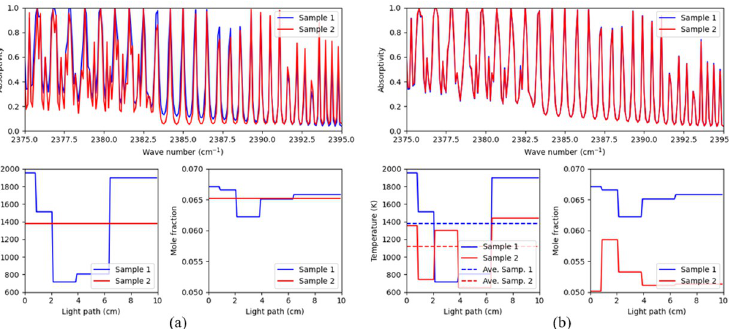
Fig 1. Two cases which occur in profile nonuniformity. In each figure, the top, bottom left and bottom right subplots represent the spectral profile, the temperature profile and the concentration profile, respectively. (a) The samples of uniform and nonuniform profiles have same average temperature and concentration but different spectral appearances. (b) Two samples have visually similar appearances but totally different temperature/concentration profiles and consequently different average